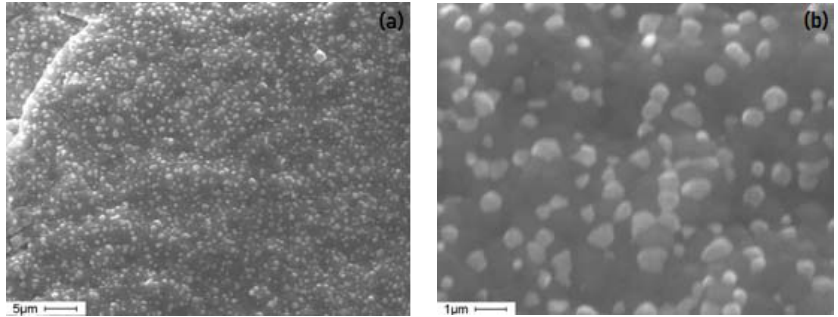
Figure 9. Images of the structure of the ceramics, generated on a scanning electron microscope: ( a ) 3000× magnification image; ( b ) 8000× magnification image.